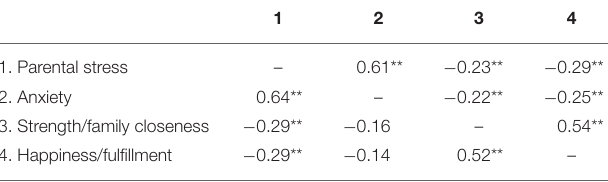
TABLE 4 | Pearson correlations between studied variables in mothers and fathers.